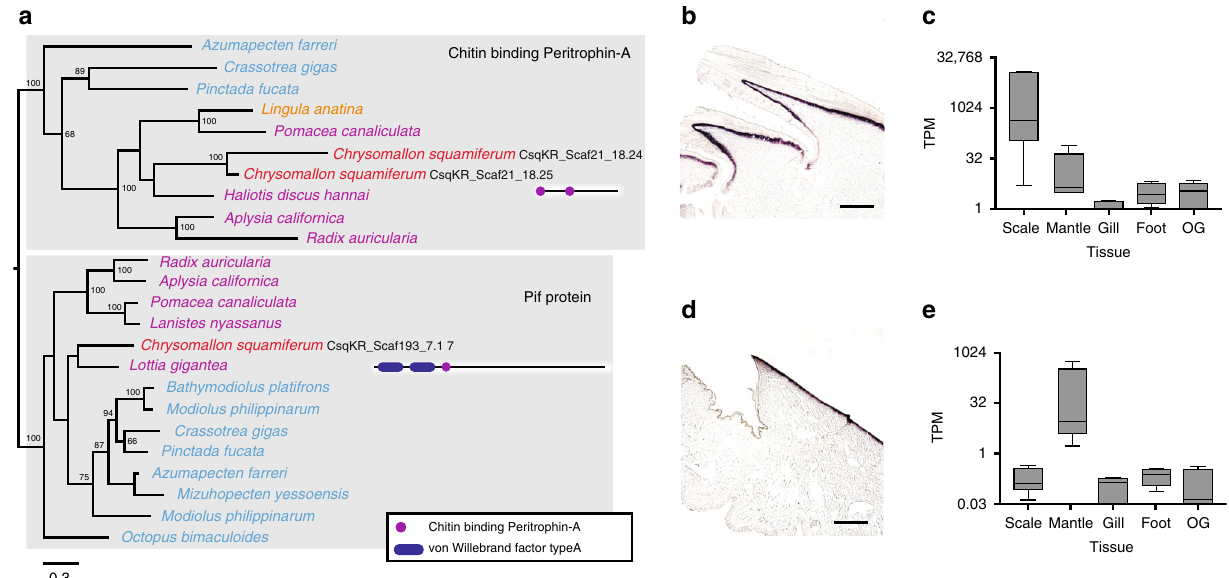
Fig. 5 Characterisation of chitin binding peritrophin-A gene and pif gene in Chrysomallon squamiferum . a Phylogenetic analysis of chitin binding peritrophin-A and pif genes with names in red indicating genes from the Scaly-foot Snail, and domain architecture of the speci fi c genes displayed on the right of names (purple indicates chitin binding peritrophin-A and blue indicates von Willebrand factor type A). b In situ hybridization of chitin binding Peritrophin-A in scales. c Boxplot showing the expression level of chitin binding peritrophin-A in fi ve different tissue types including mantle, scale-secreting epithelium, gill, oesophageal gland (OG), and foot. The box depicts fi rst to third quartile with whiskers indicating maximum and minimum expression levels, and the centre line refers to the median. Source data are provided as a Source Data fi le. d In situ hybridization showing the expression of pif gene in mantle. e Boxplot showing the expression level of pif in fi ve different tissues types. Within the Boxplot, the centre line refers to the median, and the boxplot depicts the fi rst to the third quartile, with the whiskers indicating maximum and minimum expression